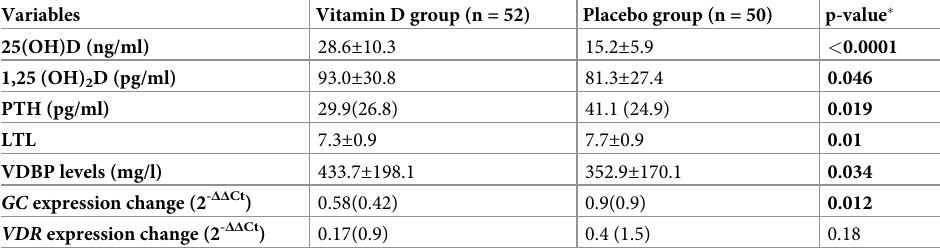
Table 5. Change in variables after treatment in vitamin D supplementation and placebo